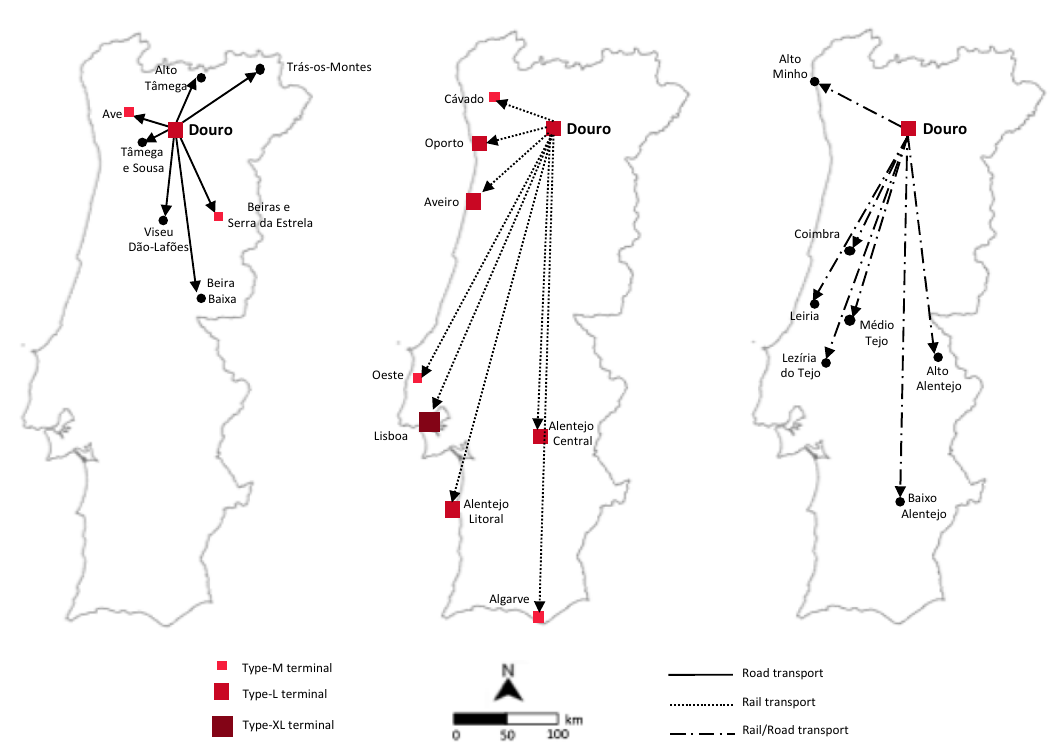
Figure 9. Optimal transport modes to use in the delivery of freight generated in the Douro Region: road ( left ), rail ( middle ) and combination of both modes ( right ).